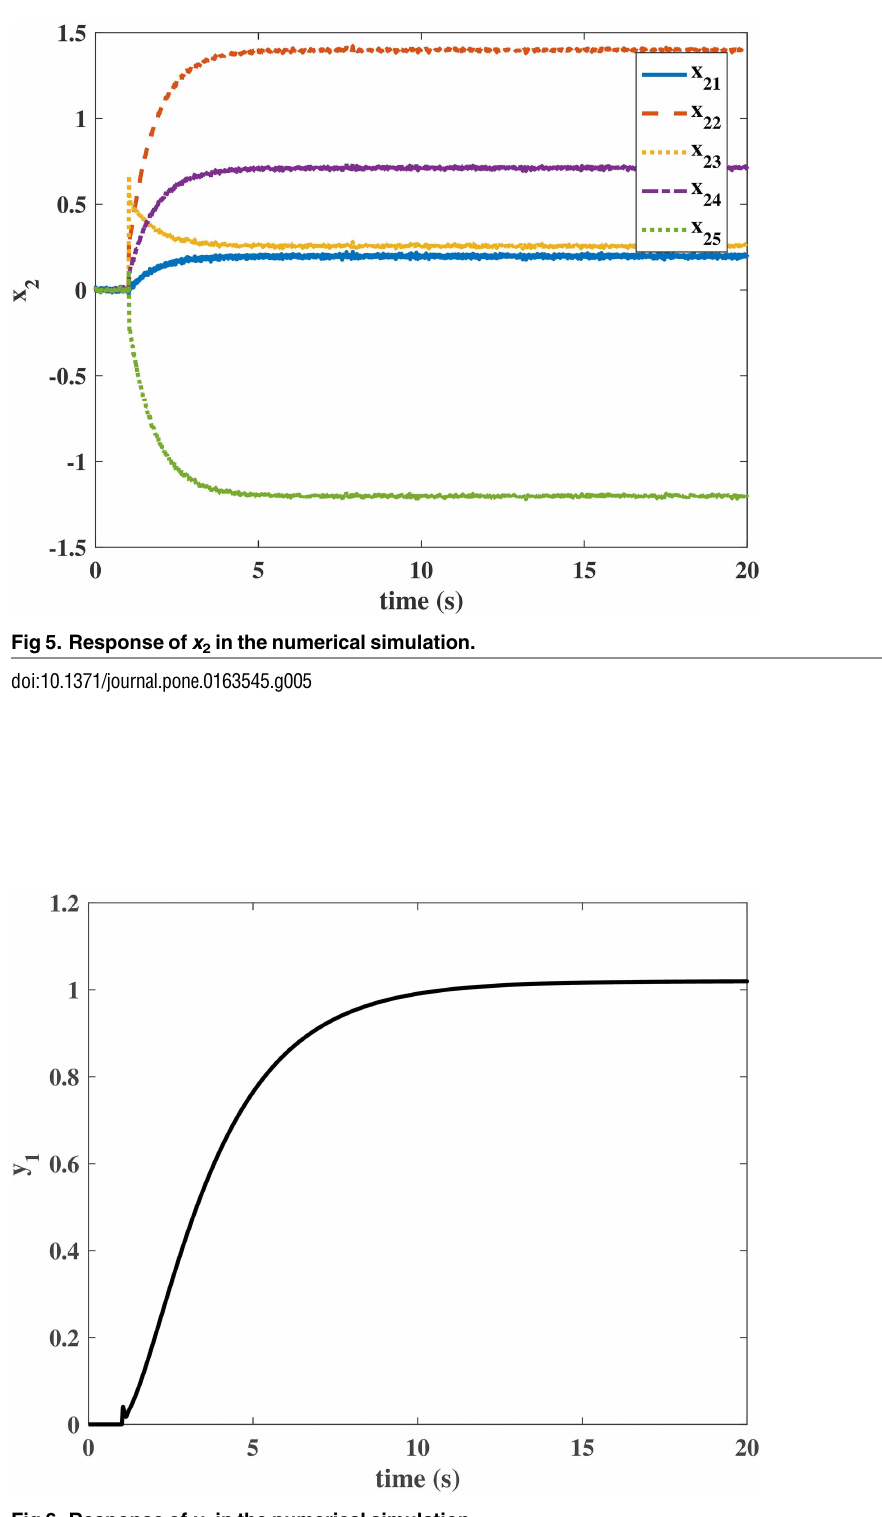
Fig 6. Response of y 1 in the numerical